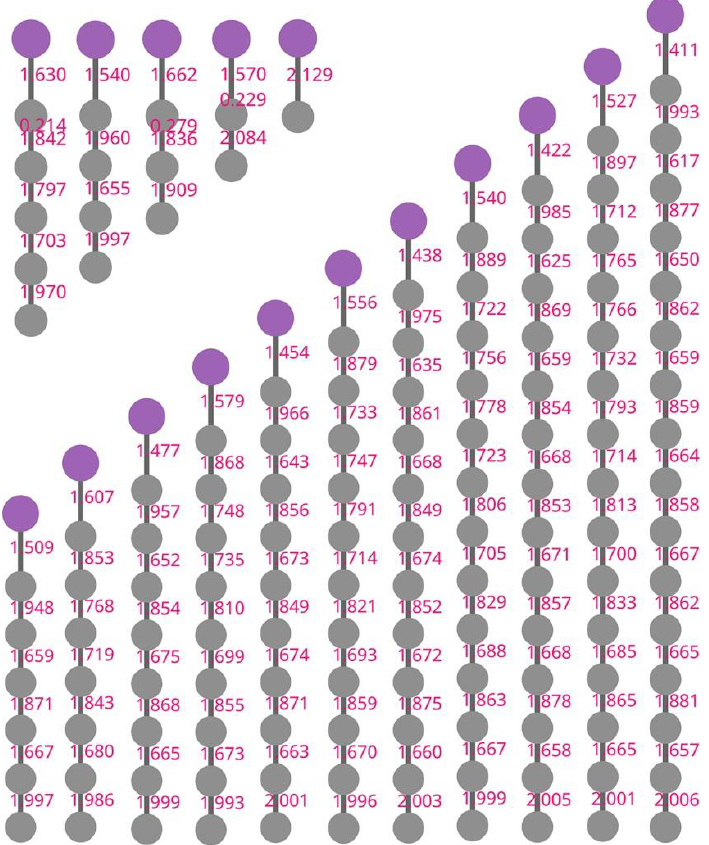
Figure 11. Computed Wiberg bond indices (WBI) for C n Sb